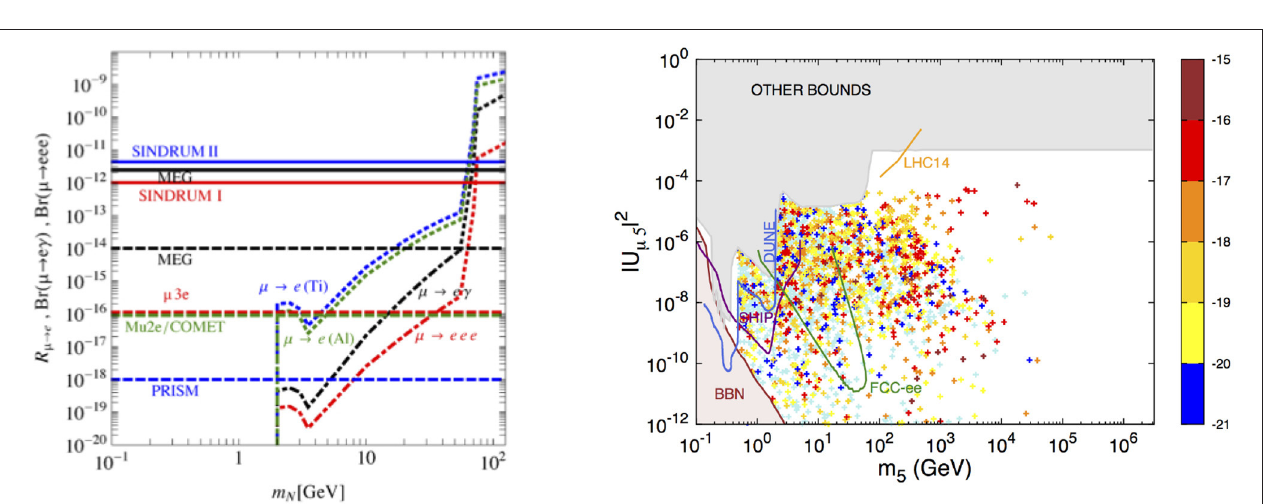
FIGURE 4 | On the (left) , effective coupling G M M ( points are in agreement will all available bounds (the horizontal lines denote the evolution of the experimental bounds and constraints); from [42], reproduced with permission from the Authors. On the (right) , correlation of cLFV in-flight σ ( µ regimes, vertical green lines denote the future sensitivities; from [54], reproduced with permission from the Authors. In both panels, gray points correspond to the violation of at least one experimental bound.